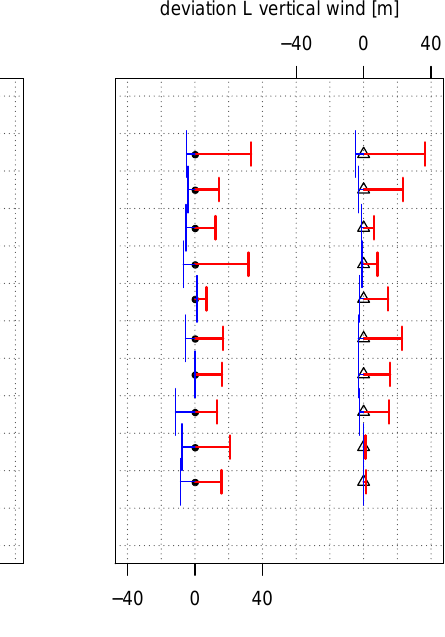
Figure 12. Height profiles of the COMPLEX flight with the altitude AMSL of the covariances Cov( w , u ) and Cov( w , v ), calculated with the calibration polynomial at v c 2 ( left ). Deviations ( right ), when applying the calibration polynomials at v c 1 and v c 3 .